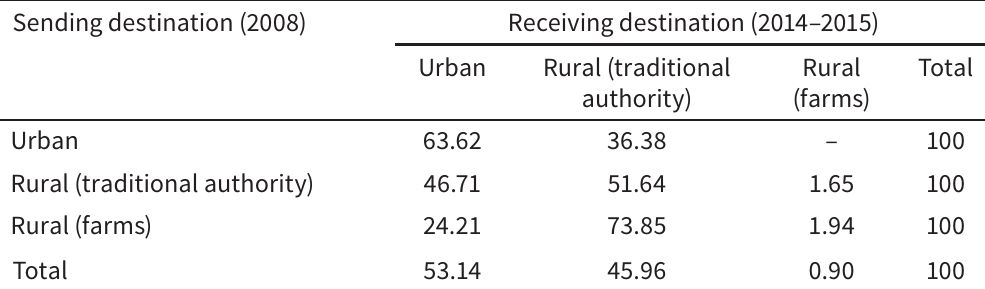
Sending and receiving geotypes for child migrants Sending destination